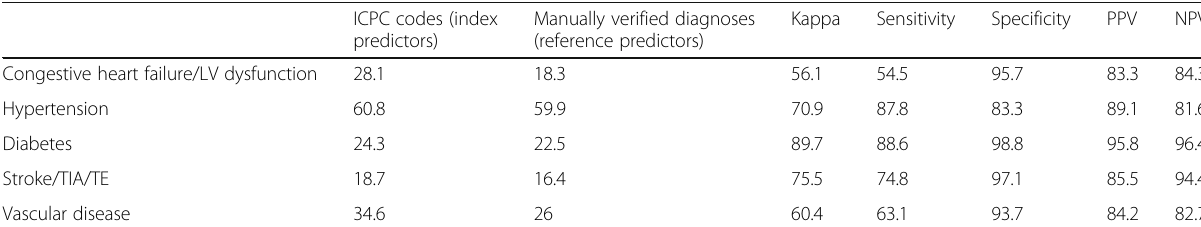
Table 4 Prevalence of individual ICPC codes (index predictors) and manually verified diagnoses (reference predictors) and measures of